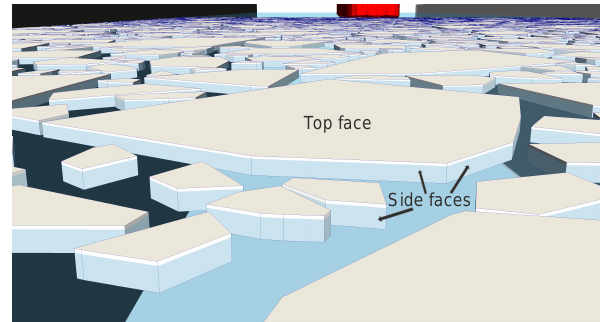
Figure 7: Ice floes in the virtual ice tank.